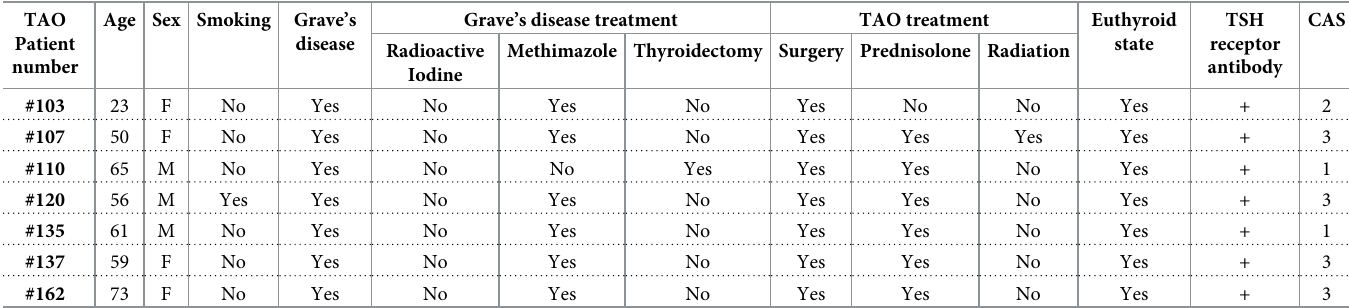
Table 1. Characteristics of patient with thyroid-associated ophthalmopathy from whom orbital fibroblasts were obtained.